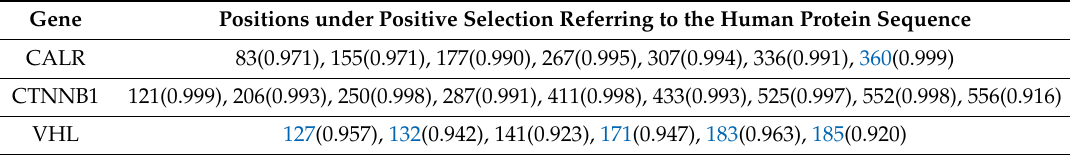
Table 1. Positive selection within disordered cancer genes. Positions within cancer risk regions are colored blue. The numbers in brackets are the posterior probability of positive selection for each